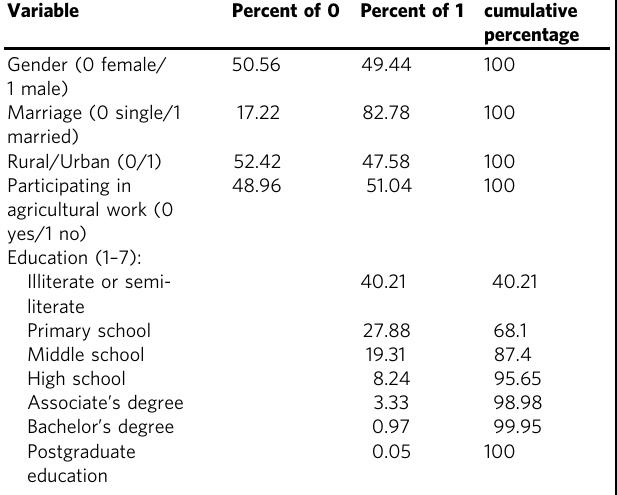
Table 2 Percentage of dummies and educational count variable for each